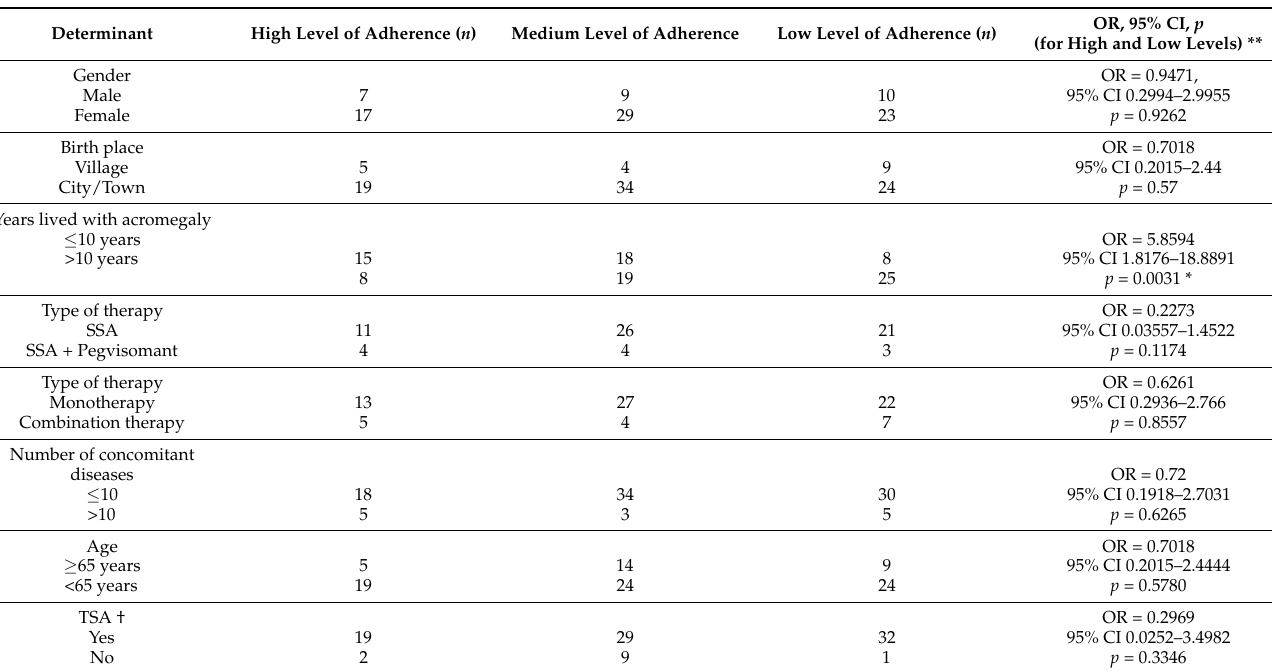
Table 5. Logistic regression